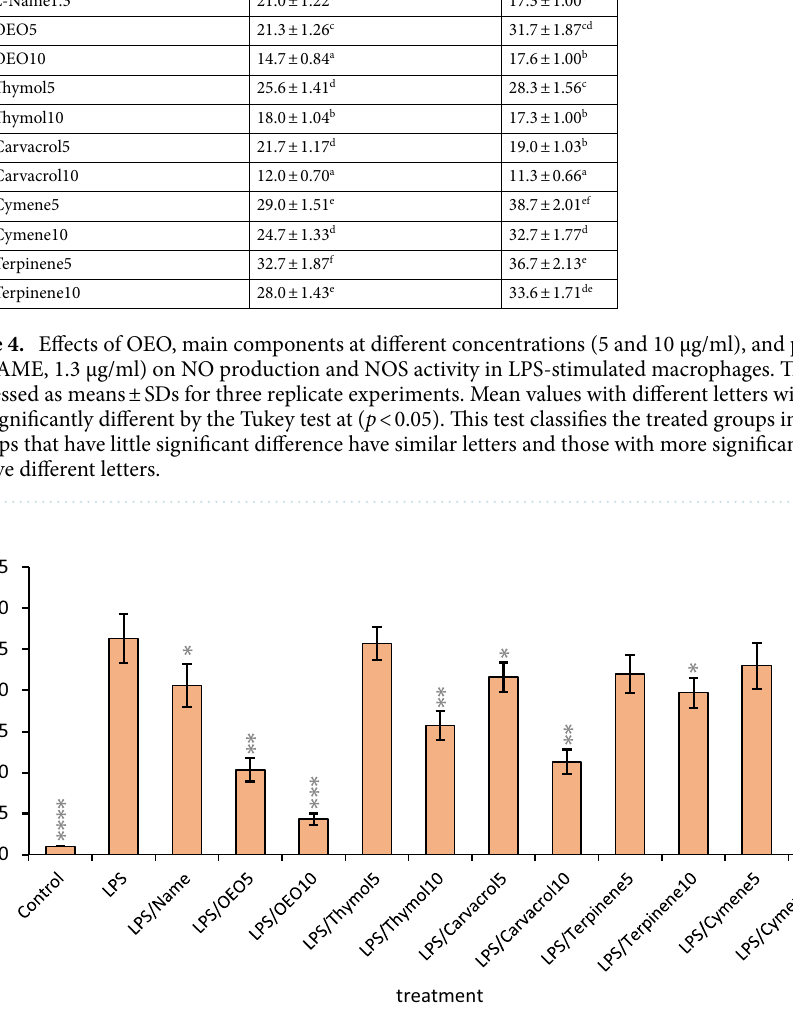
Figure 2. Effects of OEO, main components, and positive control (L-NAME) on NOS mRNA expression in LPS-stimulated macrophages. Mean values within a column are significantly different by Tukey test at *p < 0.05, **p < 0.01, ***p < 0.001 and ****p < 0.0001 versus LPS